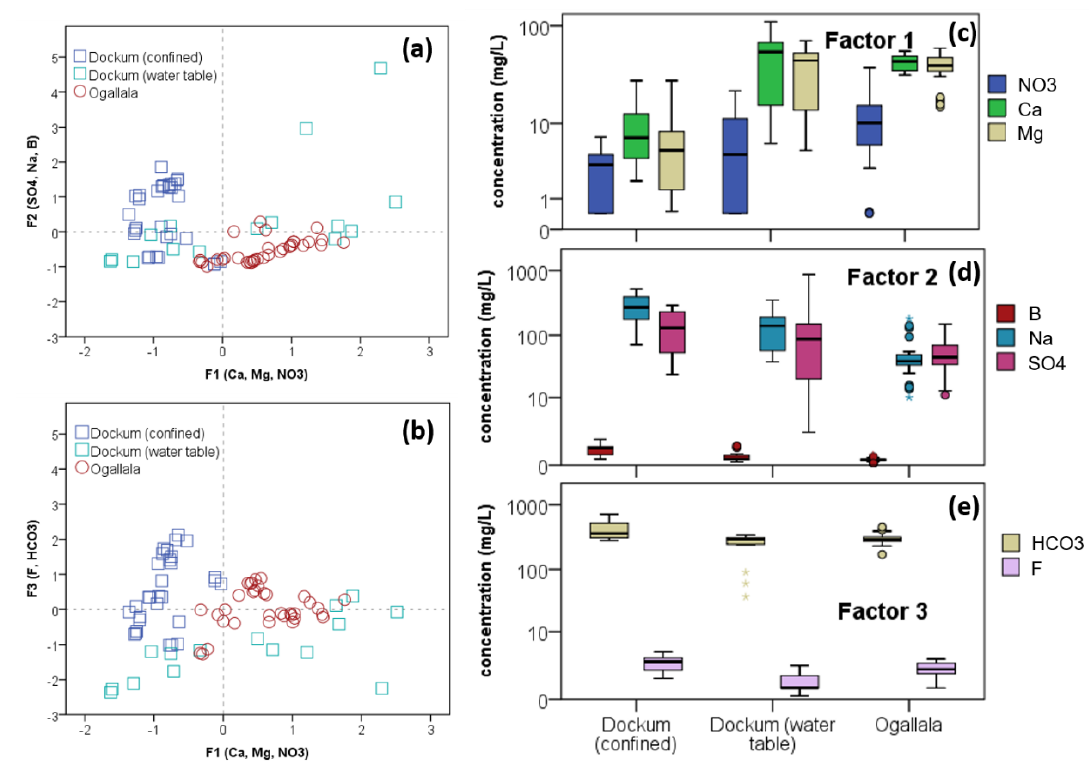
Figure 11. Individual groundwater sample PCA scores by three factors which cover 84.9% of the variation in eight constituents as ( a ) F2 vs. F1 and ( b ) F3 vs. F1. Box plot concentration comparisons between aquifer types according to constituents which are strongly positive in each factor for ( c ) Factor 1 with NO 3− , Ca 2+ , Mg 2+ , ( d ) Factor 2 with B , Na + , SO 42− , and ( e ) Factor 3 with HCO 3− and F − .